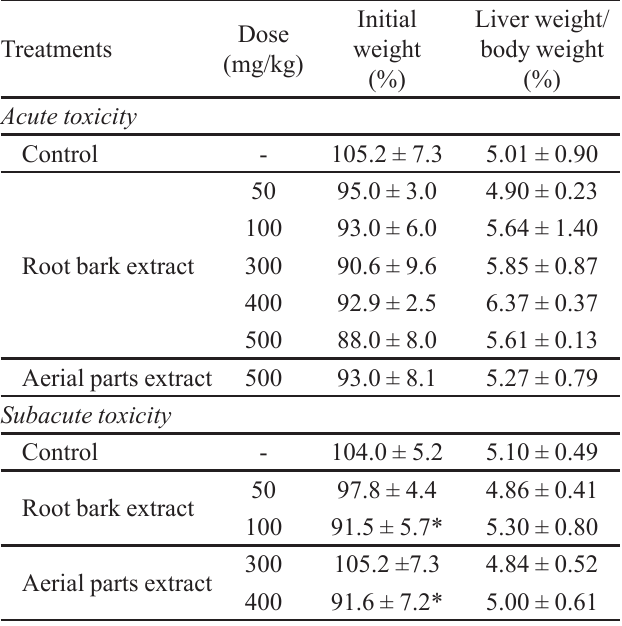
TABLE III - Effect of acute and subacute D. americana exposure on weight and liver weight/body weight of